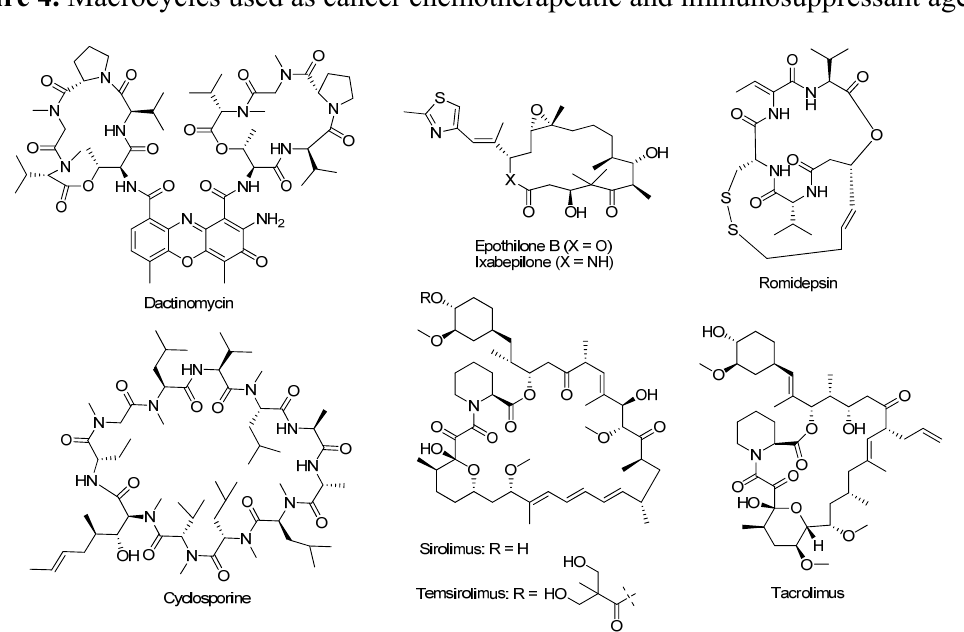
Figure 4. Macrocycles used as cancer chemotherapeutic and immunosuppressant